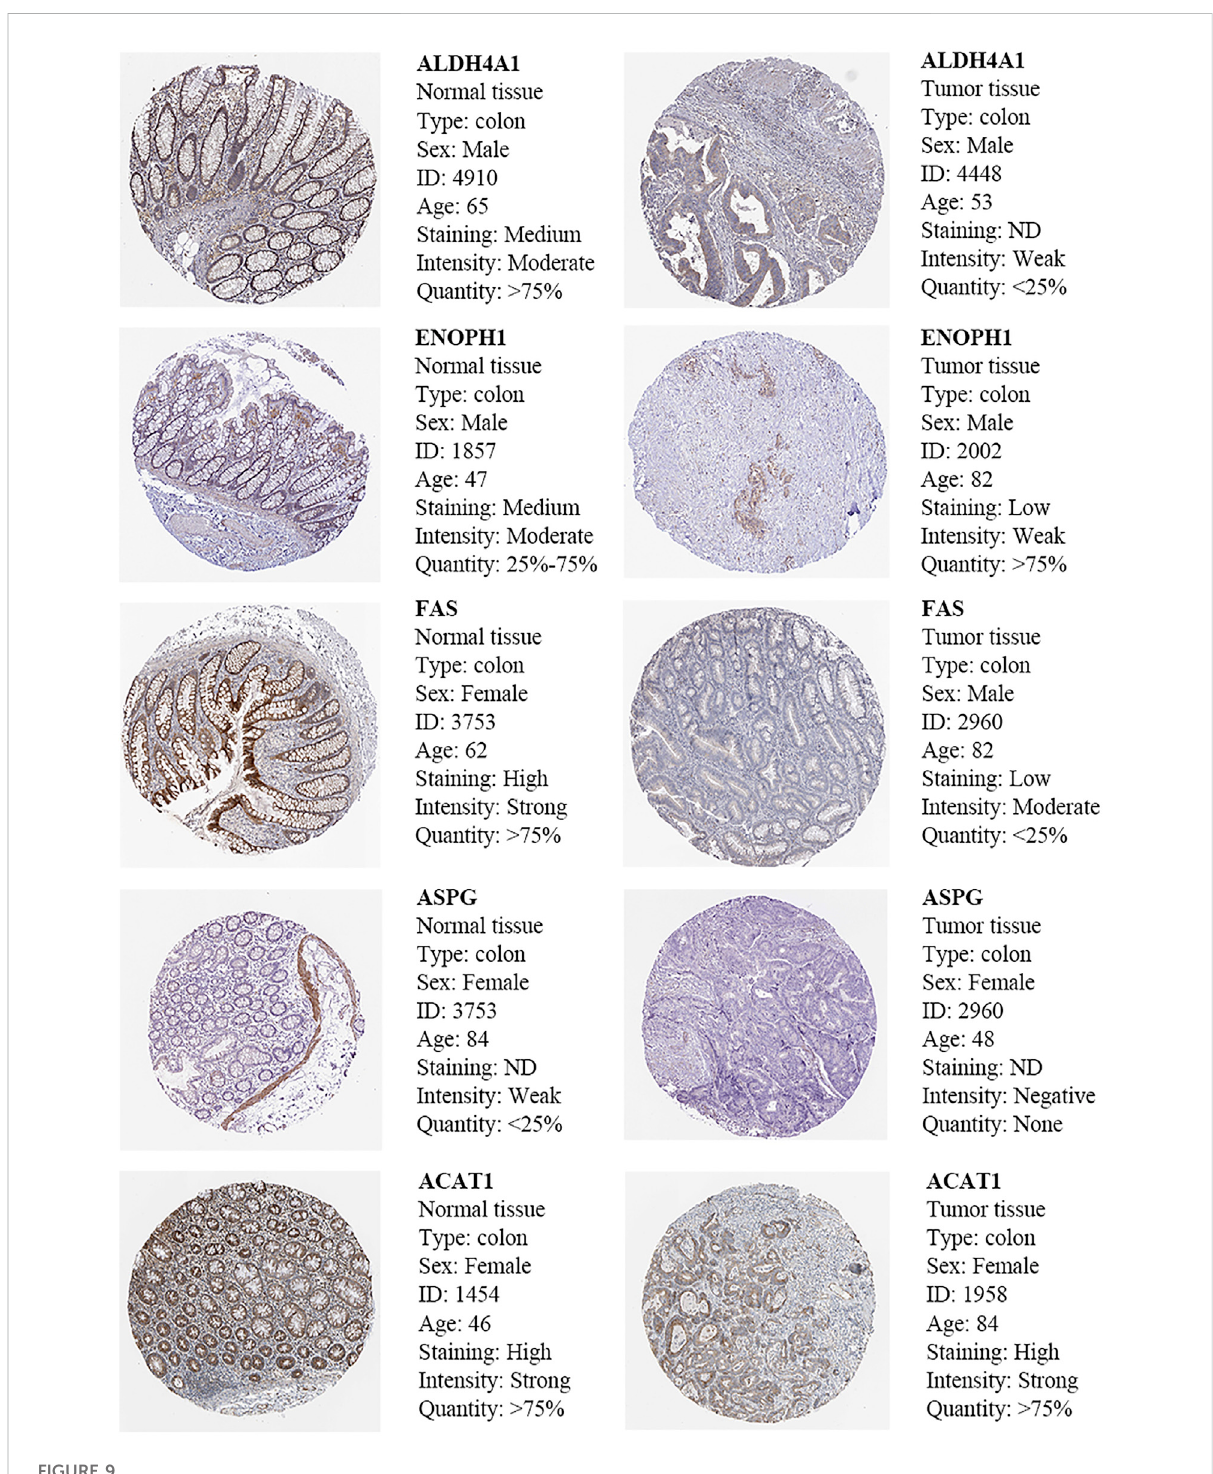
FIGURE 9 Immunohistochemistry and HE staining of fi ve prognosis-related AAMRGs in the Human Protein Atlas